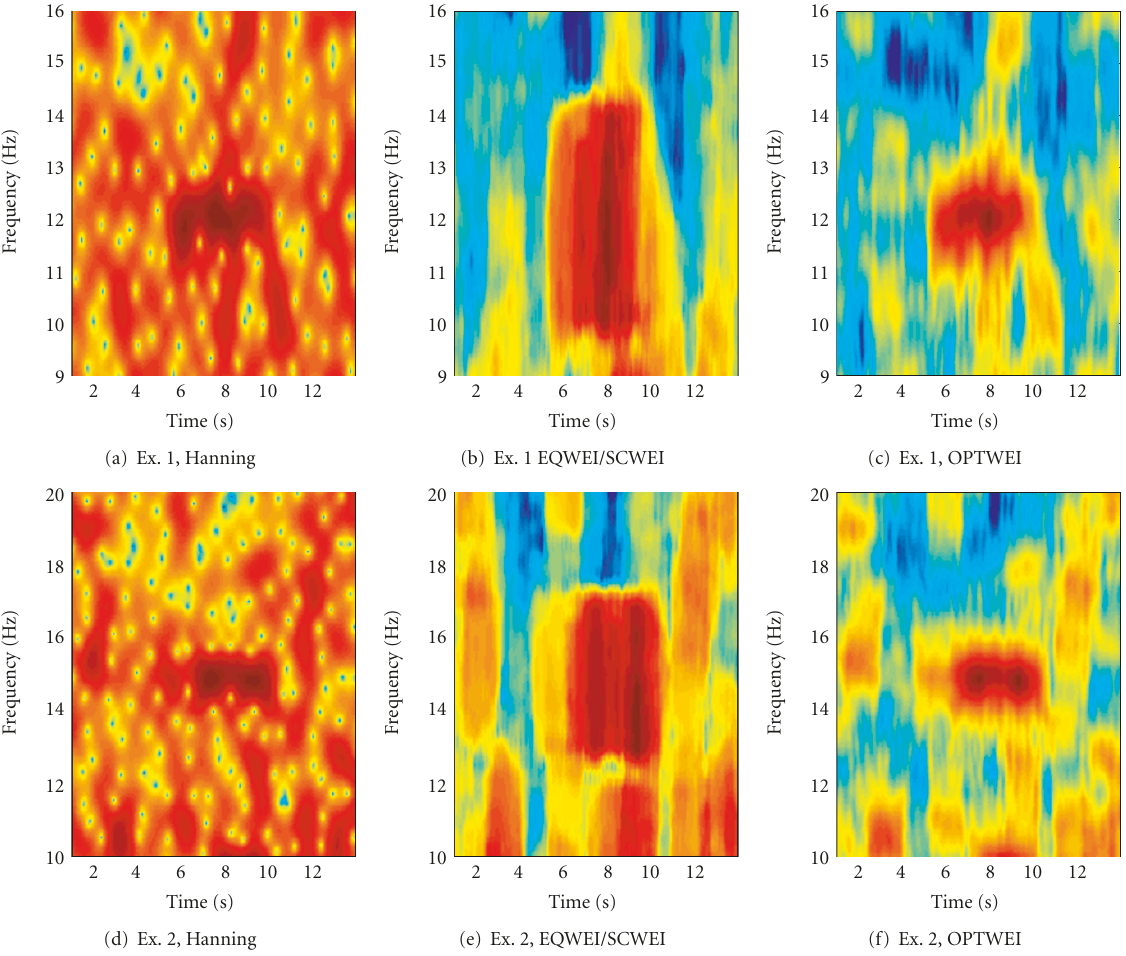
Figure 6: Logarithmic spectrogram of SSVEP of long-event nonstationary character, estimated using a single window spectrogram with a Hanning window and the Peak-Matched multiple windows with EQWEI/SCWEI and with OPTWEI from Figure 5(b). Horizontal and vertical lines indicate flickering light of (a), (b), (c) 12 Hz, 5–10 s, (d), (e),(f) 15 Hz, 5–10